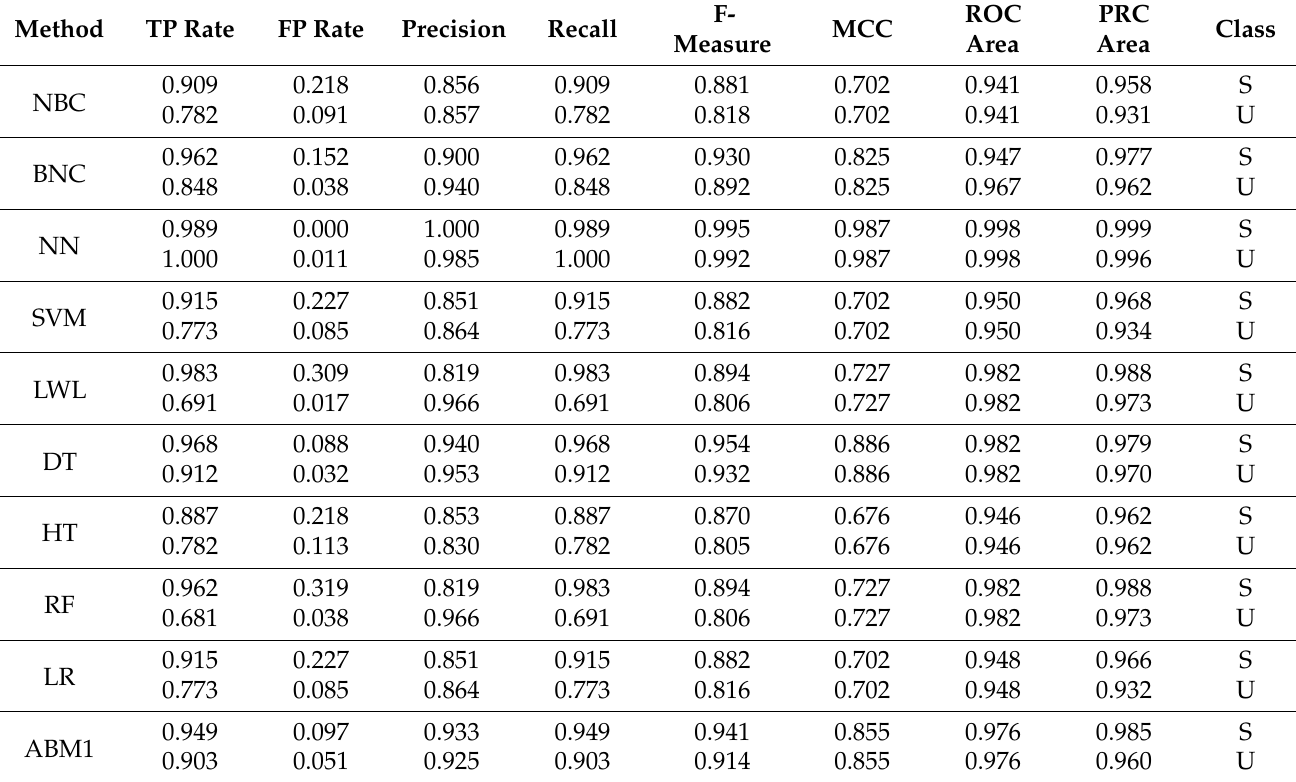
Table 2. TP rate, FP rate, precision, recall, F-measure, MCC, ROC area, PRC area, and class for each machine learning